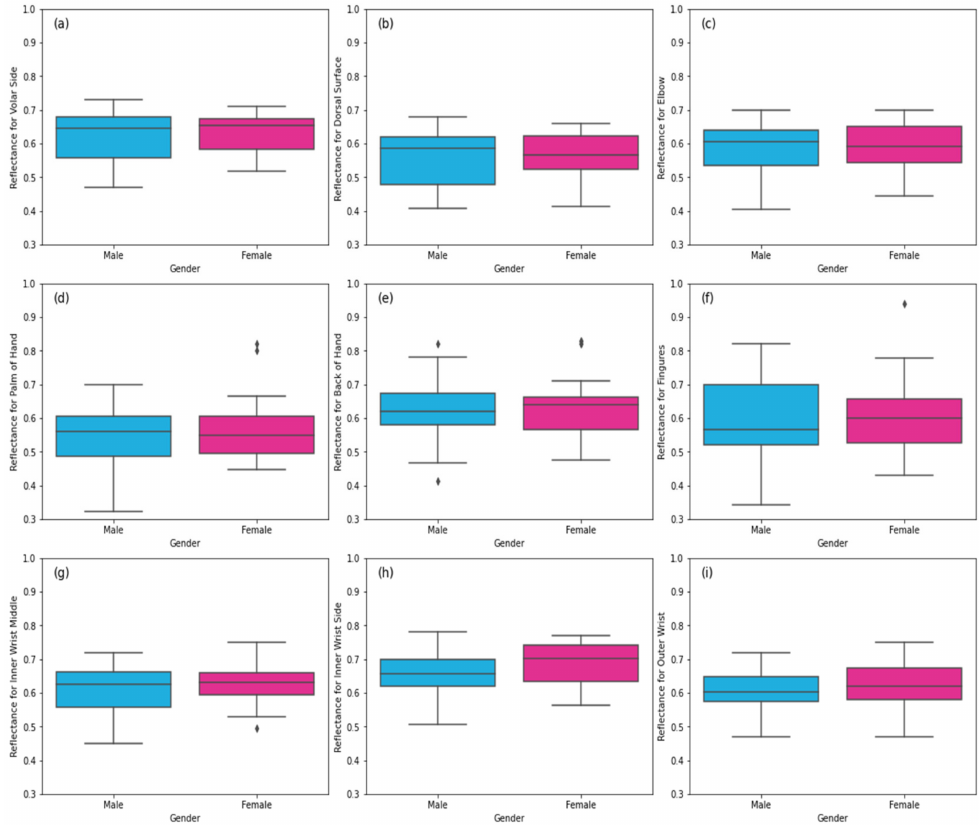
Figure 4. Reflectance measurements of healthy skin regions: ( a ) the volar side of the hand, ( b ) the dorsal surface of the hand, ( c ) the elbow, ( d ) the palm of the hand, ( e ) the back of the hand, ( f ) the finger region, ( g ) the inner wrist middle region, ( h ) the inner wrist side region, and ( i ) the outer wrist region. The symbol ( ♦ ) represents the